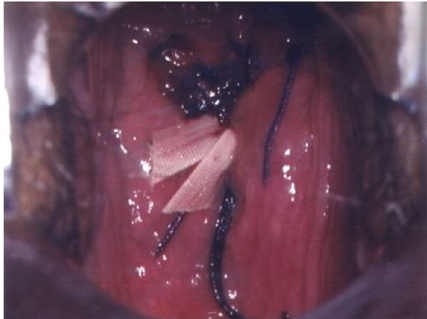
Figure 3: The cervix after vaginal trachelectomy and Shirodkar ’ s